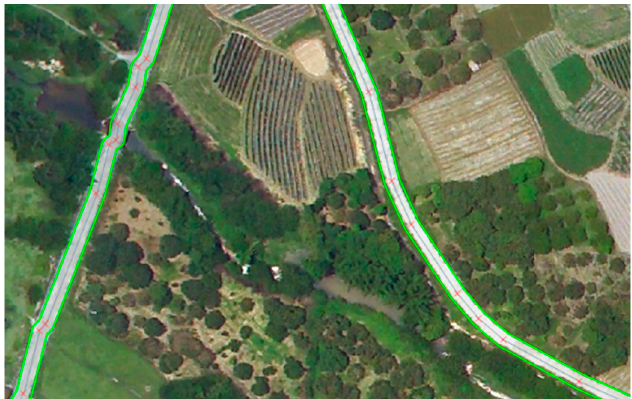
Figure 14. A road network obtained through a buffer zone.